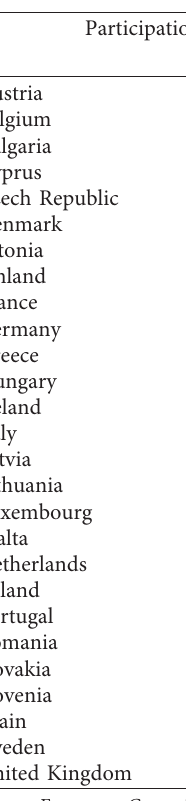
Table 1: Evolution in the participation percentage of importing countries in the intra-EU tomato market (2002–2007–2017).